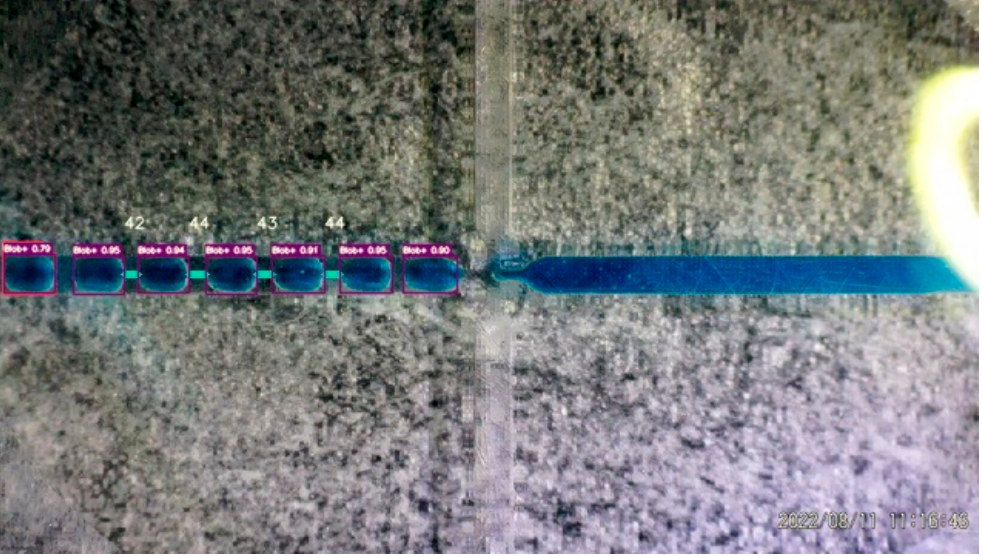
Figure 11. Determining the distance between adjacent monodisperse droplet on a digital microscope video sequence